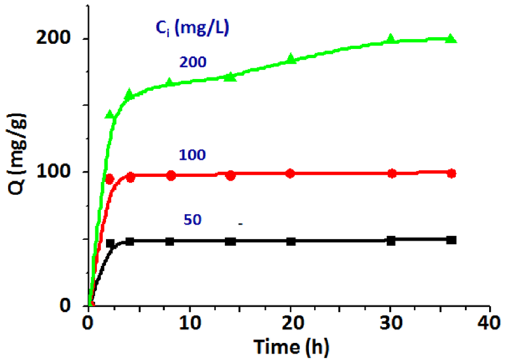
Fig. 3 Amounts of AG1 removed by 100 mg of [Zn–Al–Cl] versus contact time at various AG1 initial